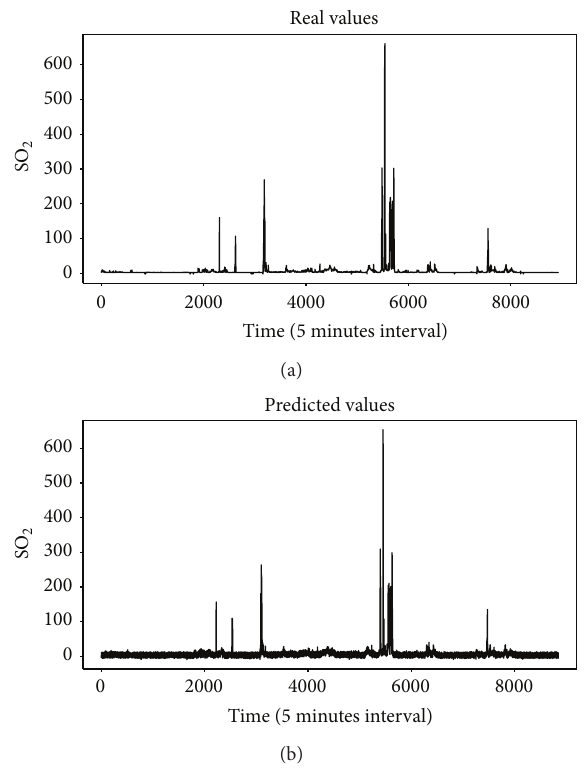
Figure 6: Hybrid model: December 2012. Real SO 2 concentration (a) versus predicted concentration